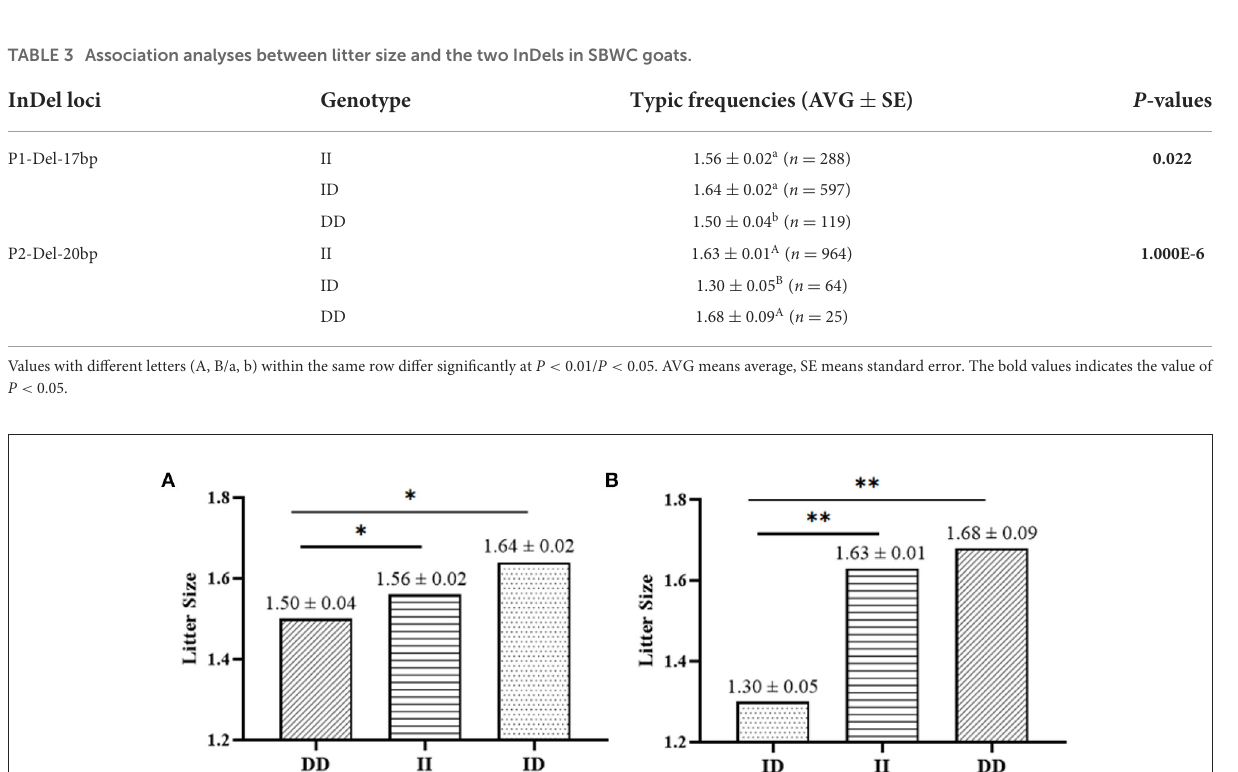
between mothers of single-lamb and multi-lamb in 2,057 SBWC goats (Table 4; Figure